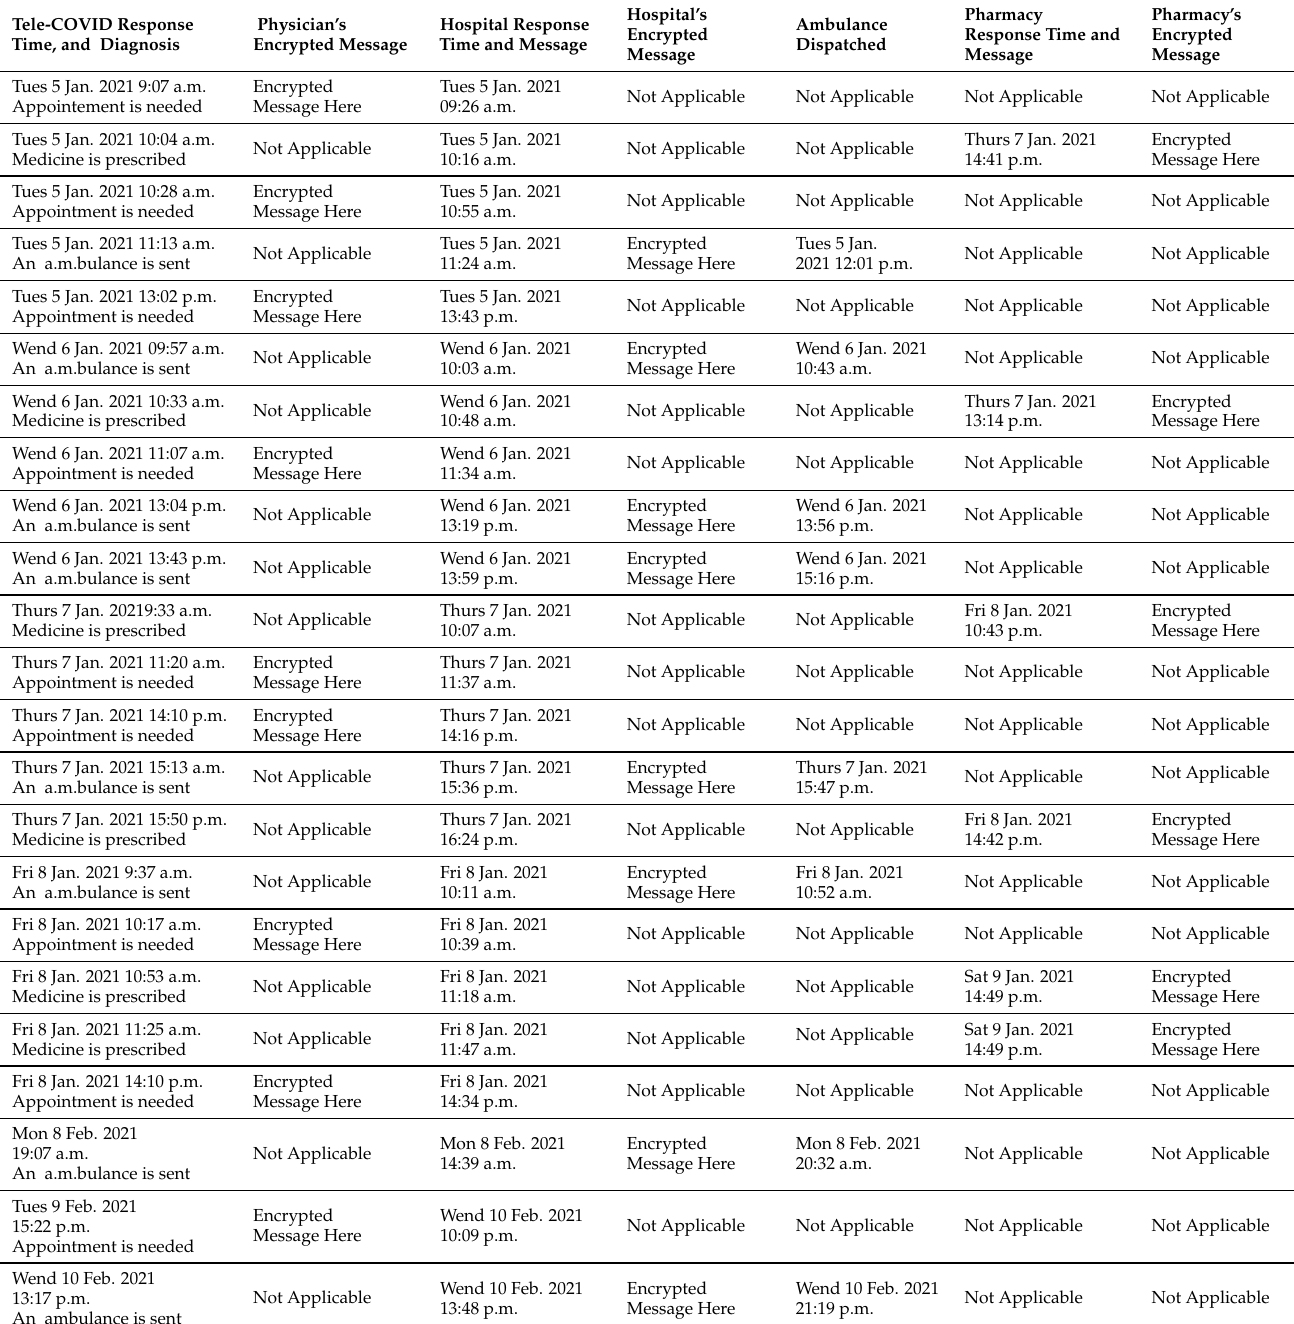
Table 2. Tele-COVID physician-hospital communication data in the county